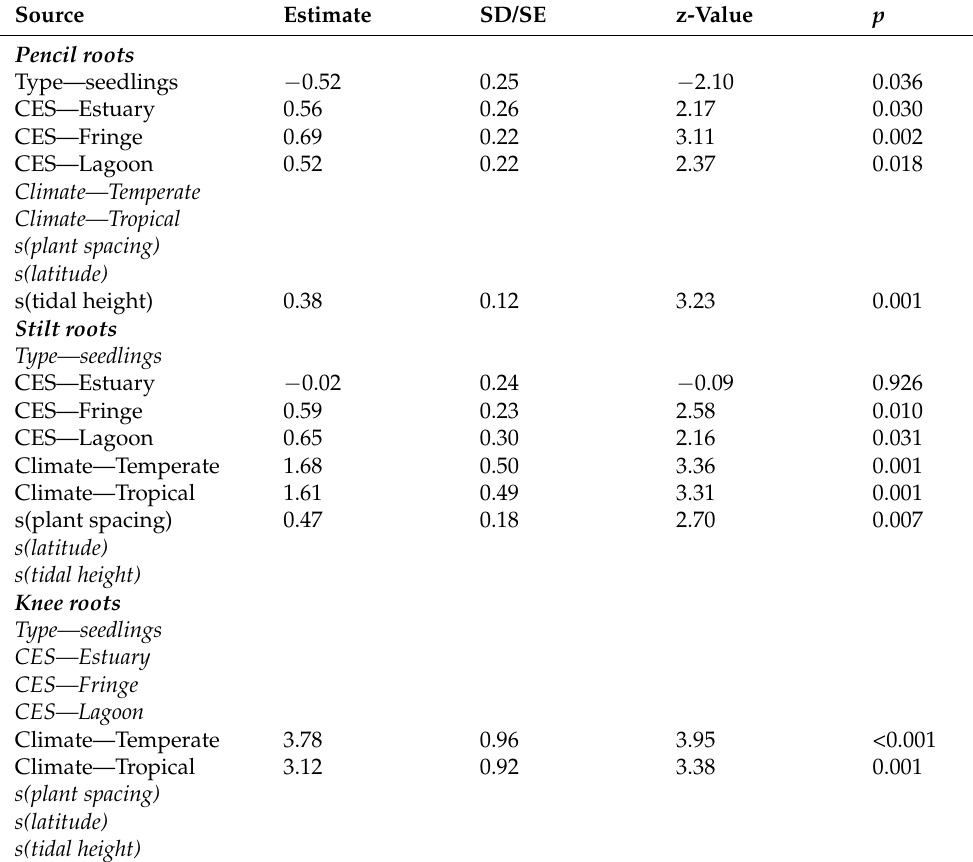
Table 1. The results of Generalized Linear Mixed Models to test the percentage survival (%) of mangrove restoration projects, with categorical factors (life history, CES and climate) treated as fixed effects, while continuous covariates (tide and plant spacing) used cubic smoothing splines, signified with ‘s()’. Terms in italics were found to be not statistically significant at p ≤ 0.05 and were removed through stepwise backward selection. SD is the standard deviation for continuous variables, SE is the standard error of the fixed effects terms and p is the p -value for the